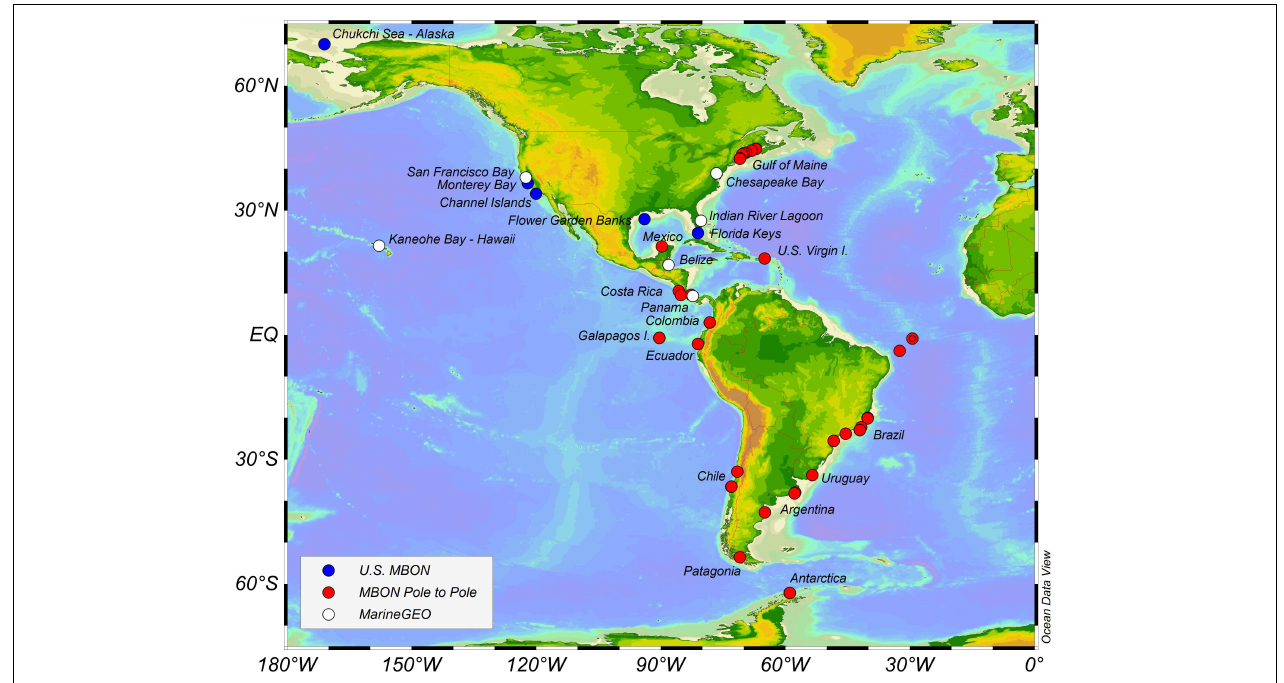
FIGURE 2 | Map of US MBON, MarineGEO, and MBON Pole to Pole in the Americas sites at the time of